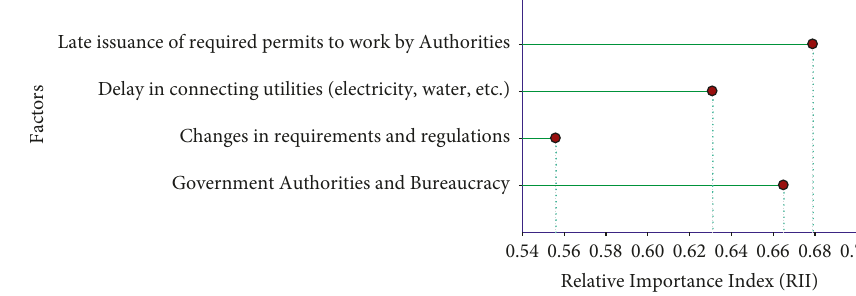
Figure 10: Ranking of Government authorities-related